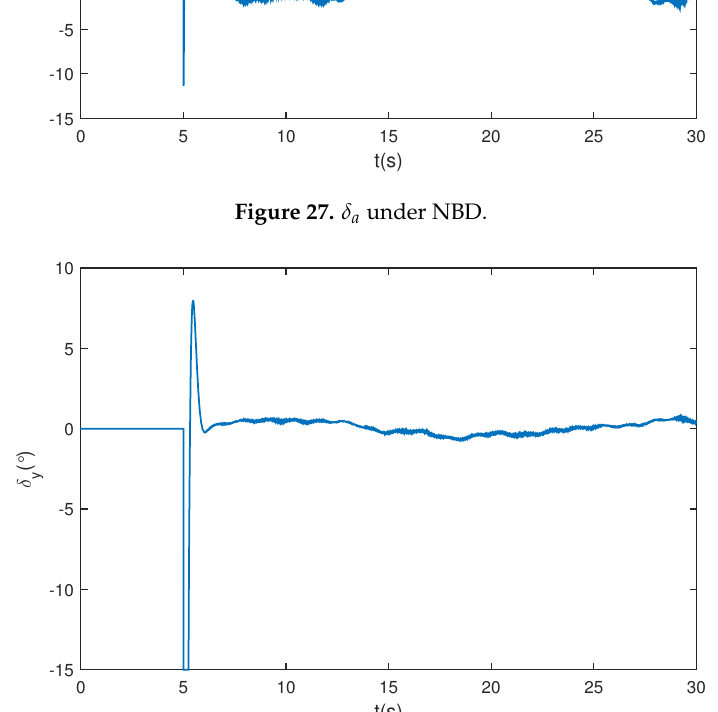
Figure 28. δ y under